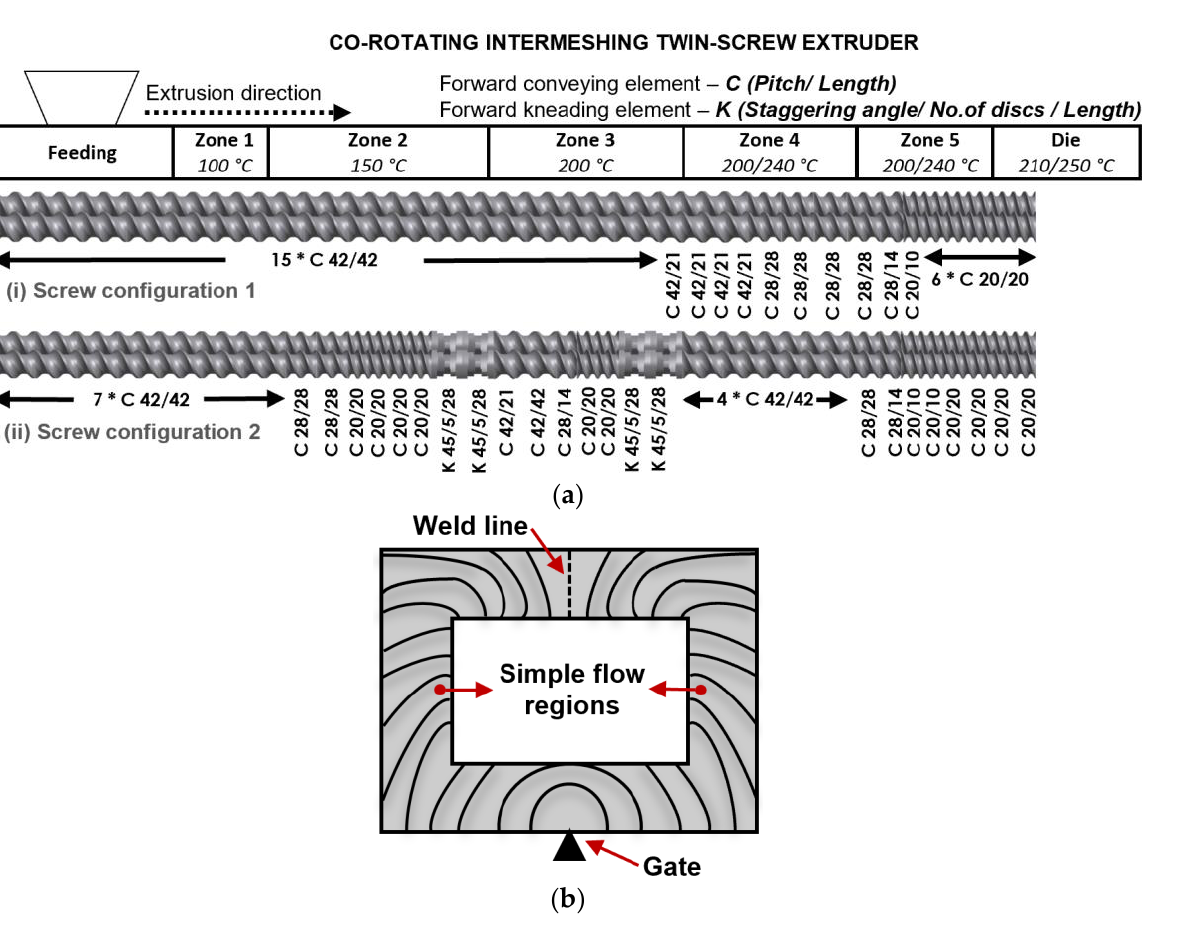
Figure 1. ( a ) The extruder screw configurations used for compounding: (i) screw 1, no mixing ele- ments; (ii) screw 2, four mixing elements; and ( b ) the filling pattern in the mold used for injection- molding, with an overall width of 64 mm, a length of 48 mm, and a thickness of 2 mm.